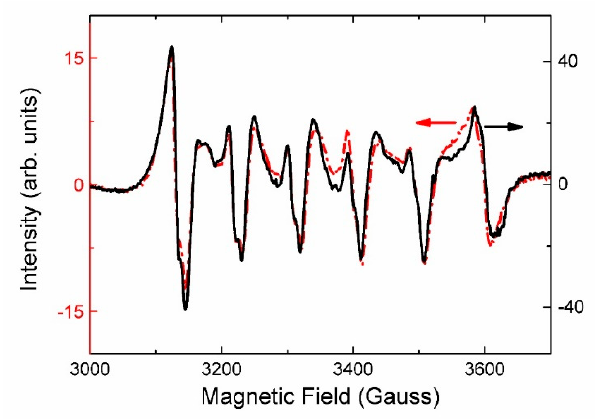
Figure 11. Infrared absorption spectra of fedorite; red dashed curve—sample Gav-43, black solid curve—sample Irk-53.